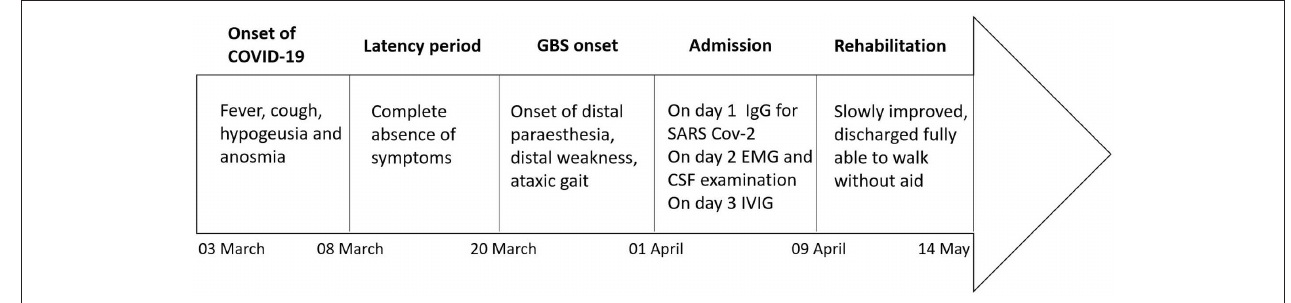
FIGURE 1 | Timeline of clinical events, diagnostic-therapeutic approach, and clinical